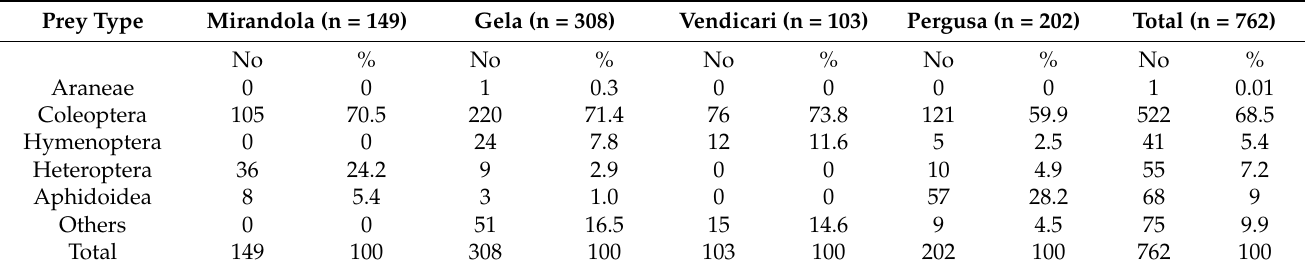
Table 2. Number of prey items per study area as identified from fecal droppings of Reed Warblers, and percentage of each selected prey category out of the total prey items recorded in each area.